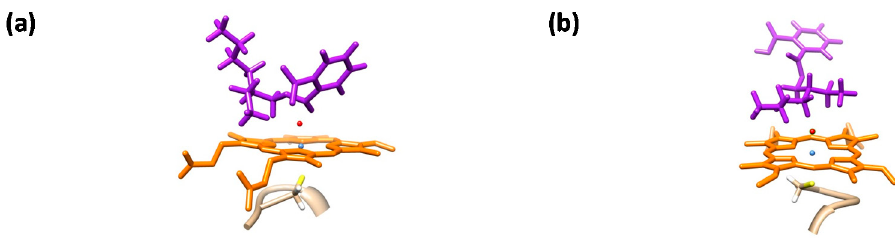
Figure 8. Two plausible conformations of the cytochrome P450 3A4 structure with phthalate substrate (SubH) docked into the substrate binding pocket: ( a ) pro-C 5 -hydroxylation binding; ( b ) pro-O-dealkylation binding.